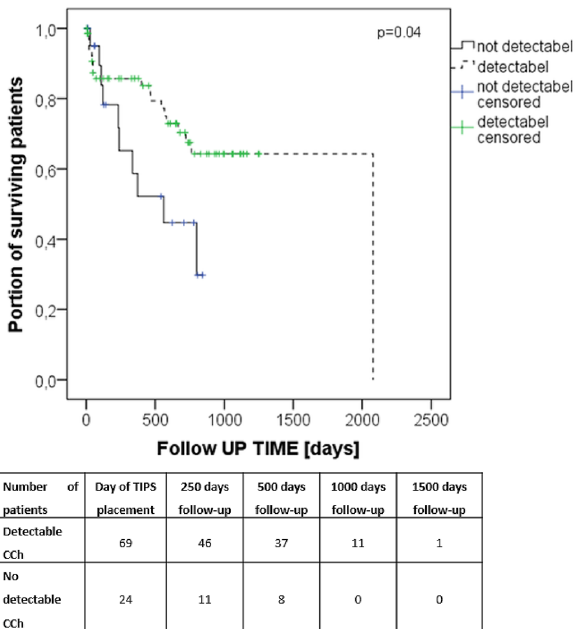
Figure 3. Kaplan Meier plot demonstrating overall survival in patients with detectable (dashed line) and without detectable cisterna chyli (solid line) as well as number of patients at risk at different time points. (IBM Corp. Released 2015. IBM SPSS Statistics for Windows, Version 23.0. Armonk, NY: IBM Corp., www. ibm.